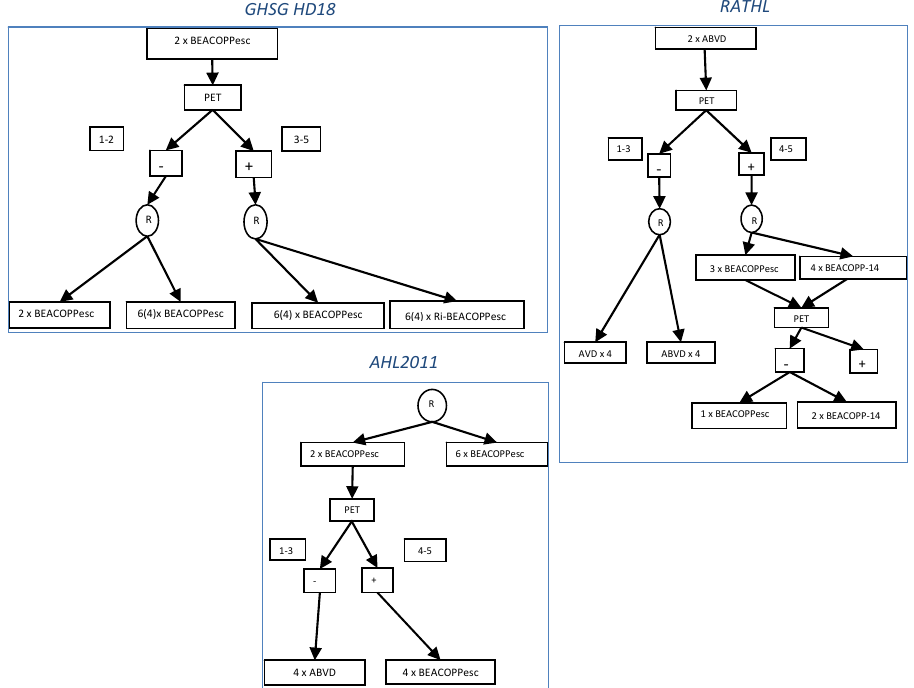
Figure 1. De-escalation and escalation strategy in the GHSG HD18, RATHL, and AHL2011 Trials. ABVD = doxorubicin, bleomycin, vinblastine, and dacarbazine; BEACOPP = bleomycin, etoposide, doxorubicin, cyclophosphamide, vincristine, procarbazine, and prednisone; BEACOPPesc = escalated BEACOPP; BEACOPP-14 = BEACOPP every 14 days; GHSG = Ger- man Hodgkin Study Group; PET = positron emission tomography; R = randomization; Ri =